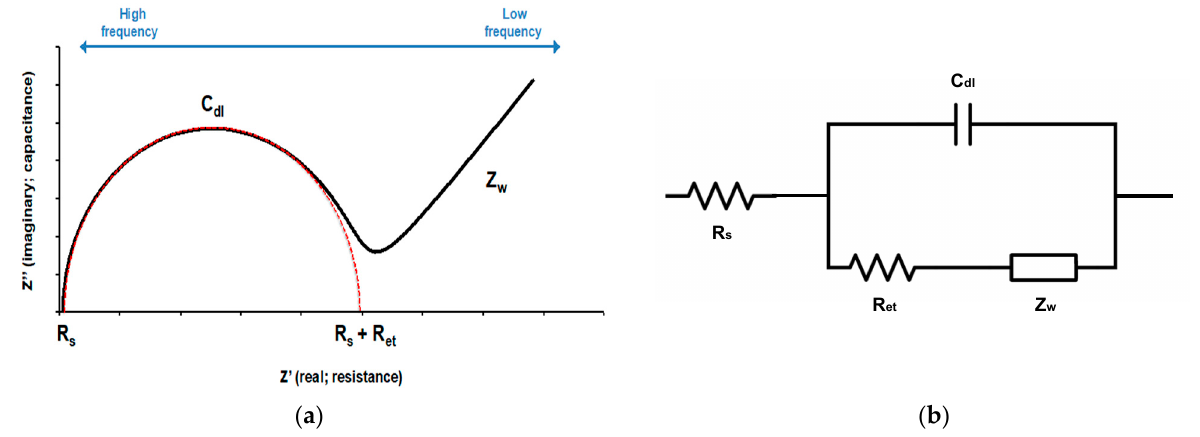
Figure 2. ( a ) A Nyquist plot for the electrochemical system under mixed kinetic and diffusion control and ( b ) Randles equivalent circuit used to fit impedance spectroscopy. Rs: electrolyte solution resistance, Cdl: double-layer capacitance, Ret: electron transfer resistance, and Zw: Warburg impedance.